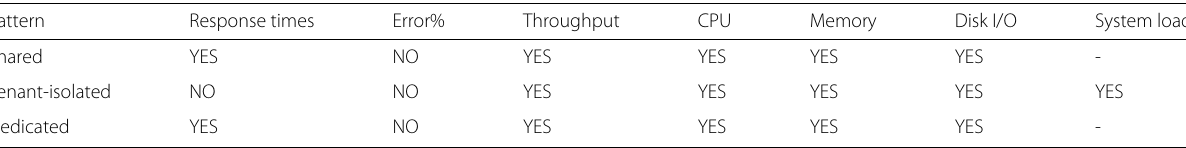
Table 4 Paired sample test analysis for case study 2